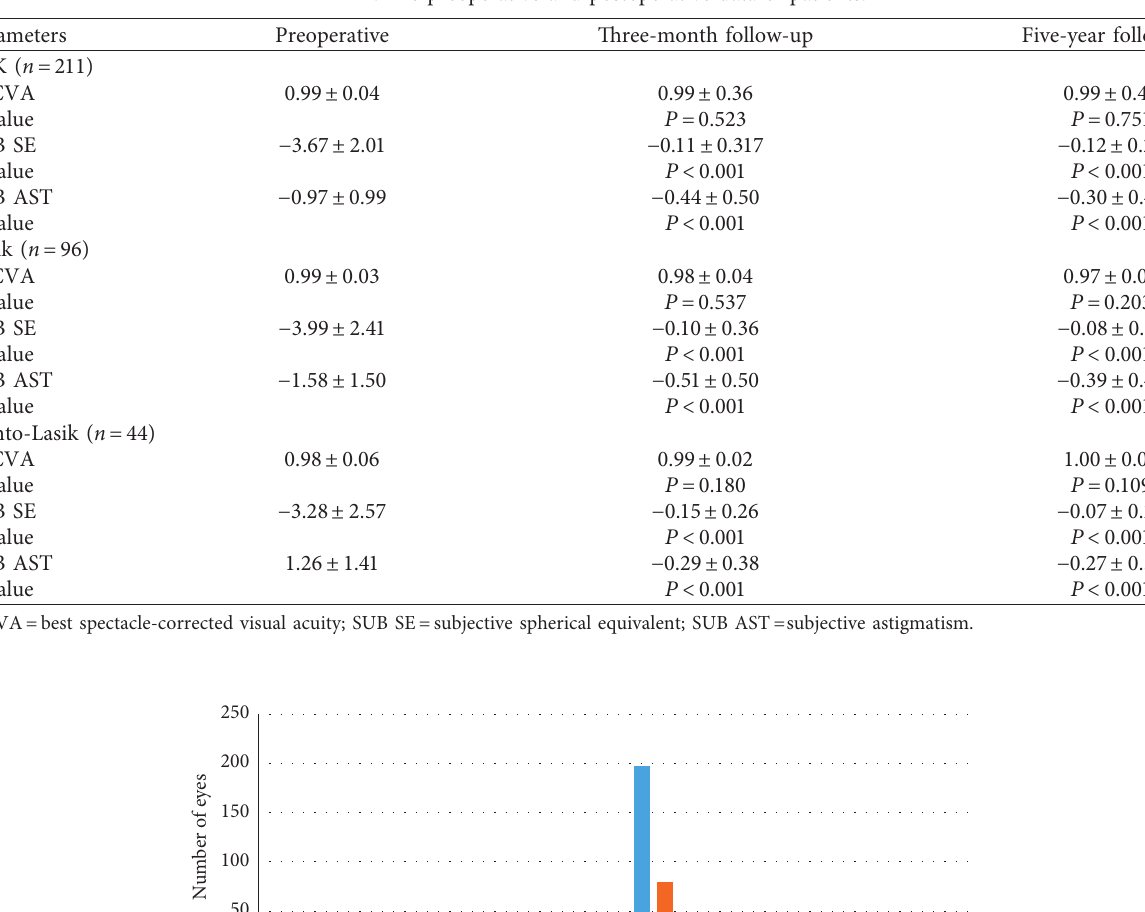
Table 1: The preoperative and postoperative data of patients.